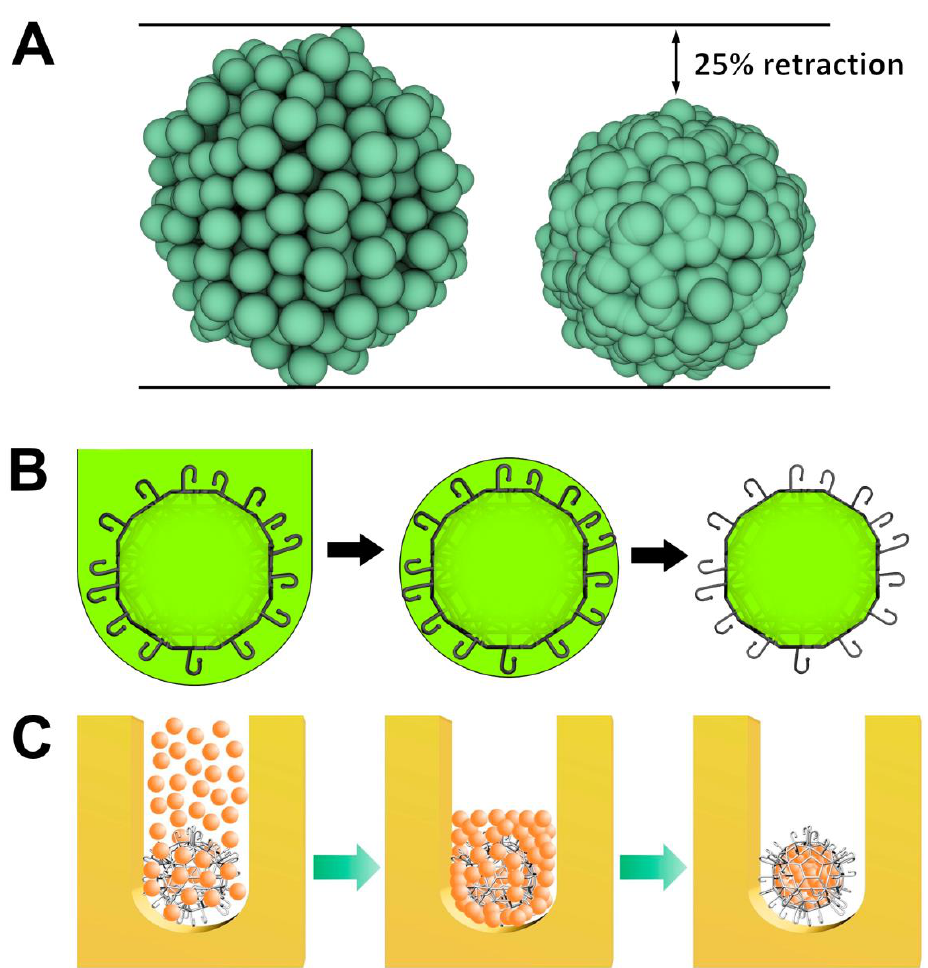
Figure 3. Mechanism of cell seeding and sequential tissue compaction in mini-scaffolds. ( A ) Mathematical modeling and computer simulation of tissue spheroid compaction using the open source software “Surface Evolver”. ( B ) Estimation of potential redistribution of cells around the mini-scaffold during tissue spheroid compaction. ( C ) Three sequential steps of cell seeding and tissue spheroid compaction around the mini-scaffold (Reprinted from [7]).